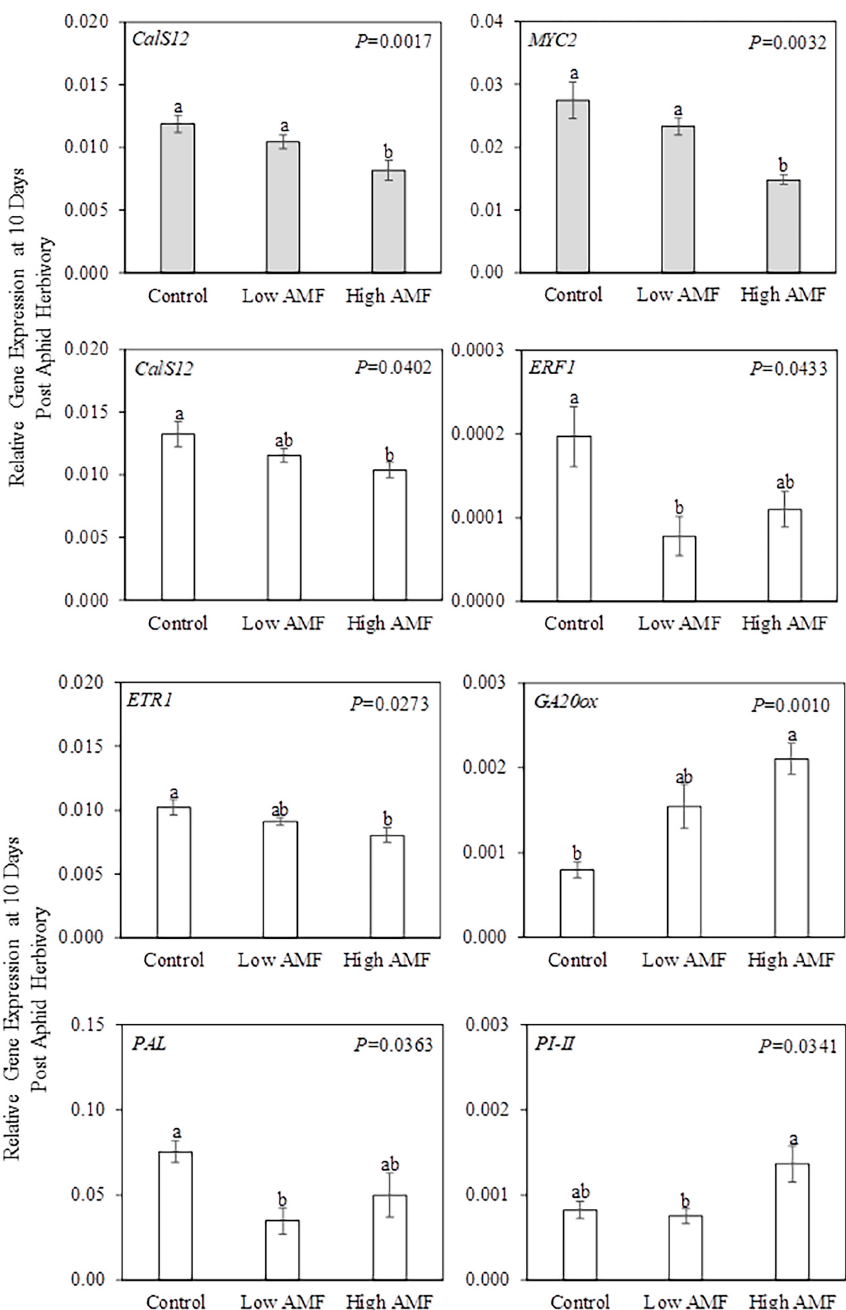
Figure 7. Relative gene expression in systemic leaf (gray bar) and roots (white bar) after 10 days of herbivory by potato aphids ( Macrosiphum euphorbiae ) on potato plants ( Solanum tuberosum ). The PA*AMF interaction was not significant in the two-factor ANOVA, but AM fungal root colonization as a main factor had a significant e ff ect (AMF p ≤ 0.05) on CalS12 , MYC2 , ERF1 , ETR1 , GA20ox , PAL, and PI-II gene expression. Values represent the mean ± SEM (n = 6 for Control / Low AMF / High AMF). The p -values from Table S2 were used to generate this figure. Di ff erent letters indicate significant di ff erence among groups based on the Tukey–Kramer test ( p ≤ 0.05). Control = non-mycorrhizal plants; Low AMF = plants with a low level of AM fungal root colonization; High AMF = plants with a high level of AM fungal root colonization. CalS12 = CALLOSE SYNTHASE 12; ERF1 = ETHYLENE RESPONSE FACTOR 1; ETR1 = ETHYLENE RECEPTOR 1; GA20ox = GIBBERELIC ACID 20-OXIDASE; MYC2 = BASIC-HELIX-LOOP-HELIX TRANSCRIPTION FACTOR; PAL = PHENYLALANINE AMMONIA LYASE; PI-II = POTATO TYPE II PROTEASE INHIBITOR